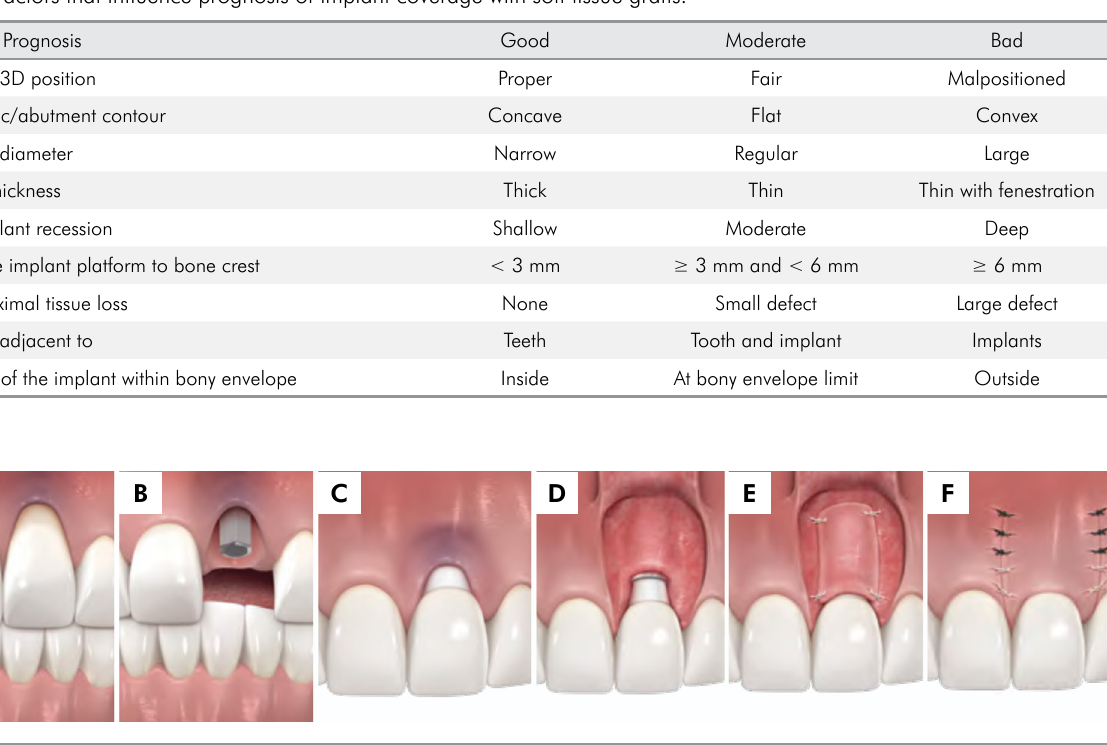
Table. Factors that influence prognosis of implant coverage with soft tissue grafts.